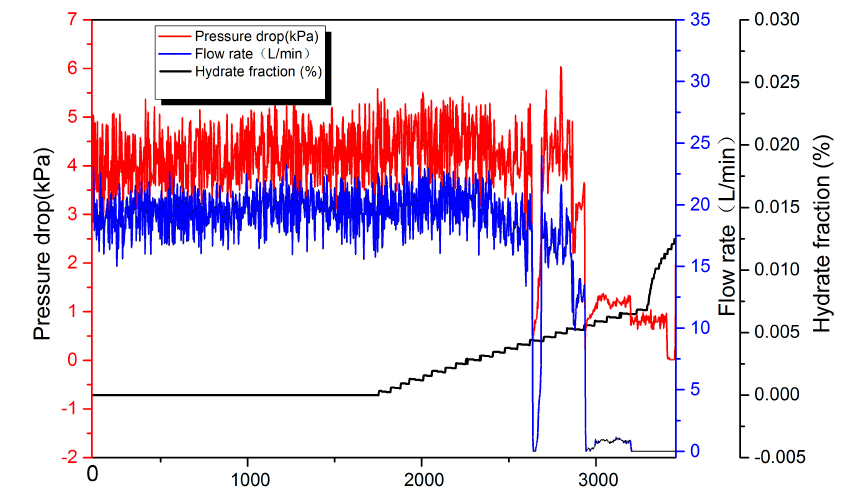
Figure 9. Flow rate and differential pressure versus time for a water cut of 80%